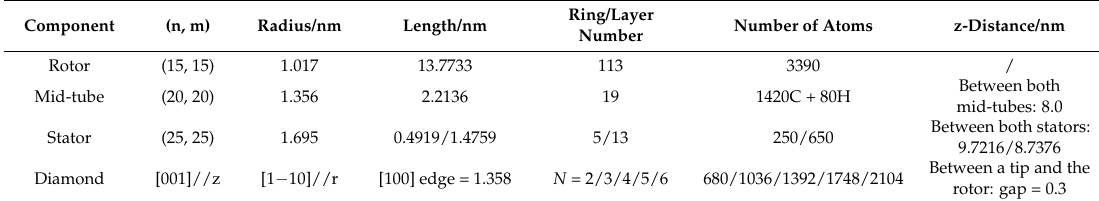
Table 2. Parameters of nanomotor models involved in simulations.